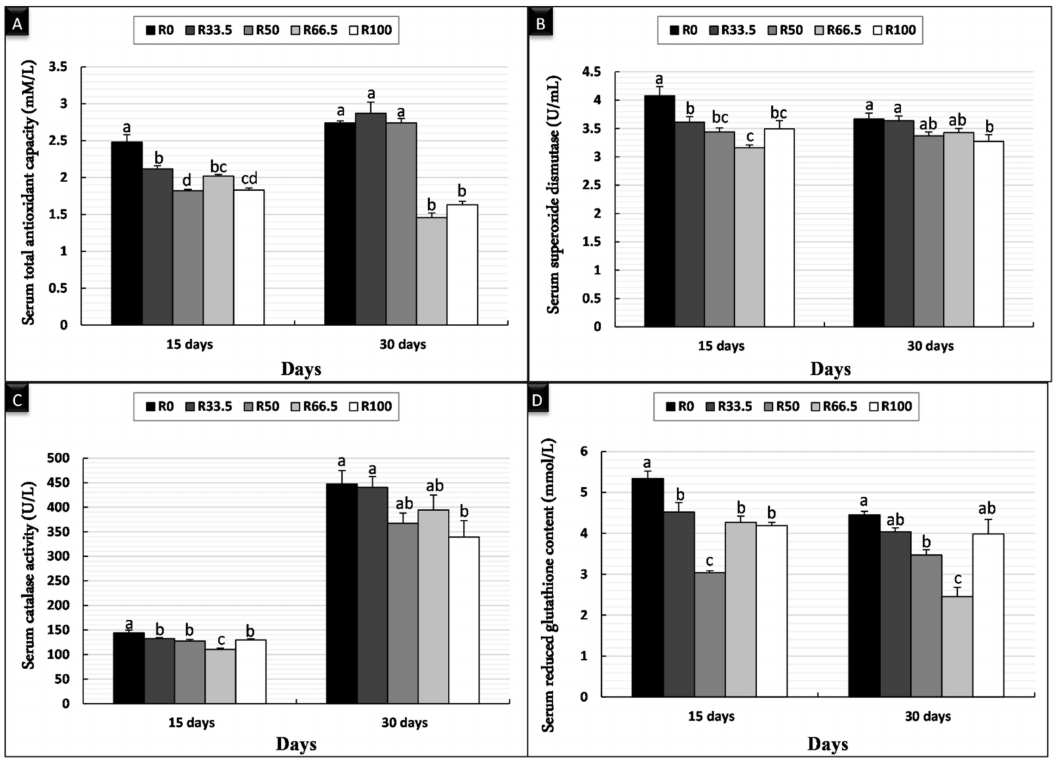
Figure 1. Serum antioxidant activity of Clarias gariepinus (mean ± SE) fed experimental diets in which fishmeal was replaced by plant protein (soybean and sunflower meal) after 15 and 30 days. ( A ) Bars indicate total antioxidant capacity (mM/L). ( B ) Bars indicate serum superoxide dismutase (U/mL). ( C ) Bars indicate serum catalase activity (U/L). ( D ) Bars indicate reduced serum glutathione content (mmol/L). Groups with different superscripts (a, b and c) were significantly different ( p < 0.05, using one-way ANOVA to detect the difference among groups within the same period). R0 (control group) = fish fed normal base diet. R33.5, R50, R66.5, and R100 = fish fed diet, with fishmeal replaced by 33.5, 50, 66.5 and 100% plant protein (soybean and sunflower meal),